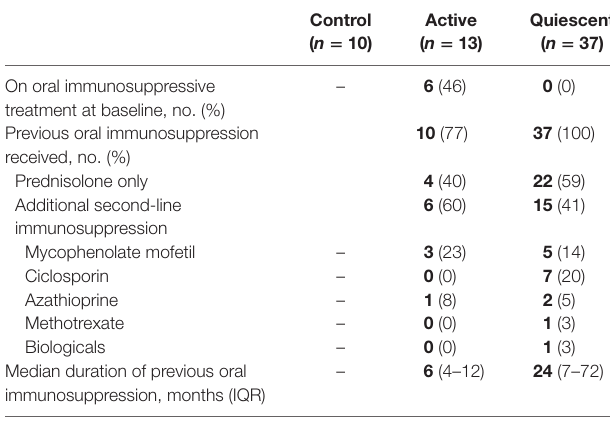
TaBle 2 | Subject immunosuppressive treatment characteristics.